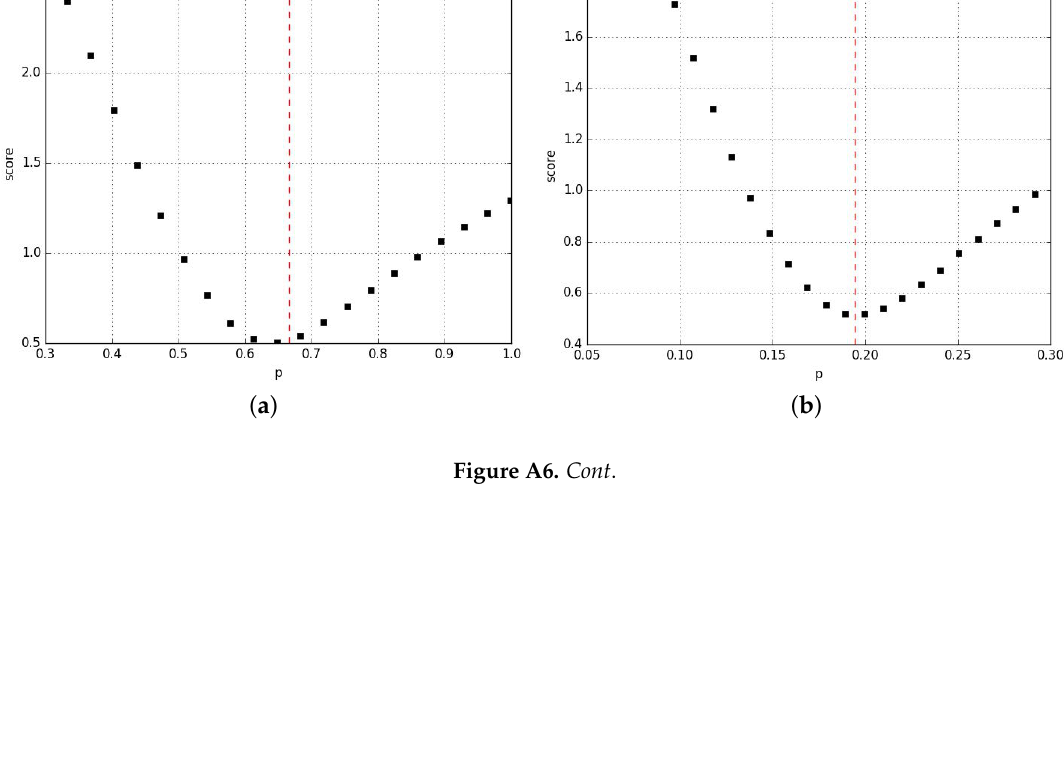
Figure A5. Diatom growth in MM simulation results. The parameters δ A , v cons are varied by ± 10% (( a – c ) respectively) and by ± 50% (( d – f ) respectively).